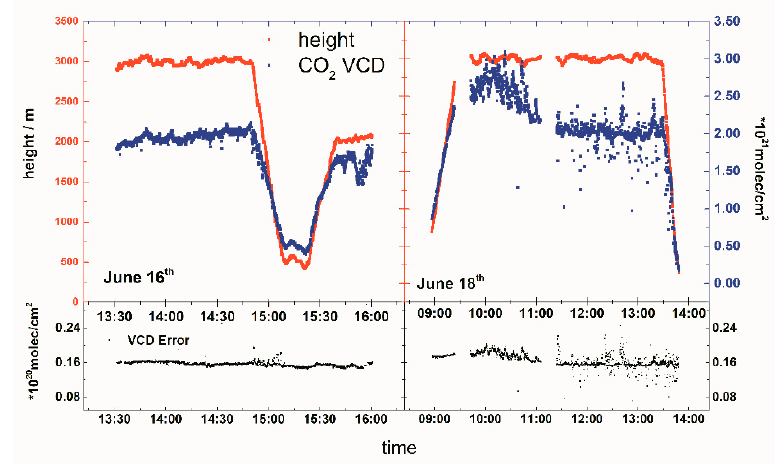
Figure 13. Time series of CO 2 column, height, and retrieval errors during flight.